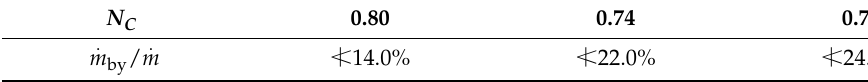
Table 1. The objective aerodynamic performance at different rotating speeds.